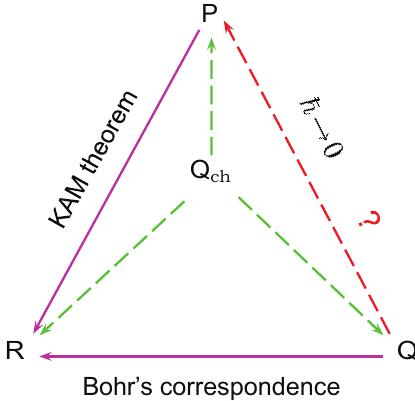
Figure 4. The figure shows a diagram of the interconnections between the three well-known regions of matter motion R , P , Q and the new region Q ch , which is strictly defined in this paper. Recall that R denotes classical regular systems (Newton systems), P denotes classical dynamically or chaotic systems (Poincaré systems), Q denotes regular quantum systems and Q ch -quantum chaotic systems. There is a possibility of passing from the P system to the R system, which is ensured by the KAM-theorem [68]. From the system Q , a transition to the system R is possible, but not to the system P , while from the system Q ch there is the possibility of transition to all three R , P and Q